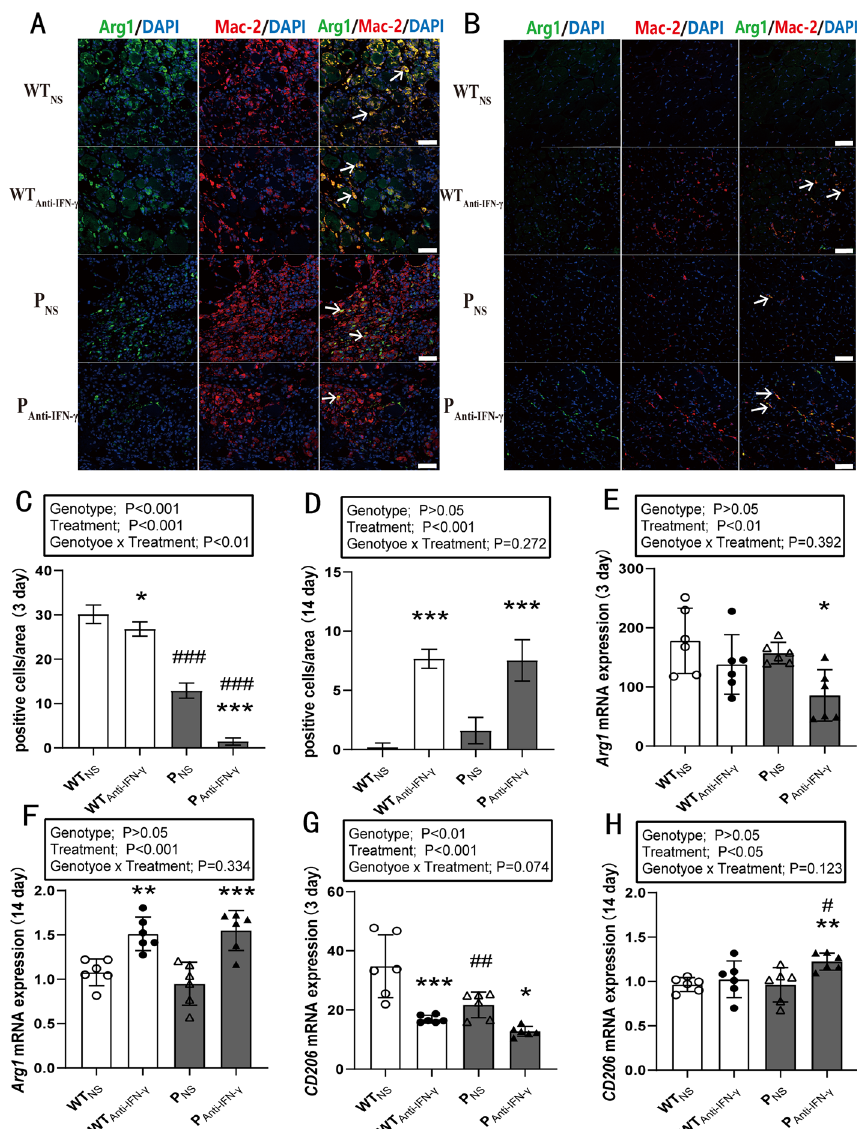
Fig. 5 IFN-γ blockade after PD-1 knockout reduces anti-inflammatory macrophage activation in injured skeletal muscle. WT NS : wild-type injured group with normal saline injection, WT Anti-IFN-γ : wild-type injured group with Anti-IFN-γ antibody injection, P NS : PD-1 − / − injured group with normal saline injection, P Anti-IFN-γ : PD-1 − / − injured group with Anti-IFN-γ antibody injection. A Representative double immunofluorescence staining of Arg1 and Mac-2 at 3 days post injury, B representative double immunofluorescence staining of Arg1 and Mac-2 at 14 days post injury, C quantification of anti-inflammatory macrophages per field as in A , D quantification of anti-inflammatory macrophages per field as in B , E Arg1 mRNA expression at 3 days post injury, F Arg1 mRNA expression at 14 days post injury, G CD206 mRNA expression at 3 days post injury, H CD206 mRNA expression at 14 days post injury. * P < 0.05, ** P < 0.01, *** P < 0.001, different from NS treatment when comparing the same genotype. # P < 0.05, ## P < 0.01, ### P < 0.001, different from WT mice when comparing the same treatment. Data are shown as mean standard deviation (SD), n 3 ( C , D ), n 6 ( E – H ). ± = = White scale bar, 50 μm. Anti-inflammatory → (AKT) phosphorylation induced by TGF-β stimulation, thereby reducing muscle fibrosis [43]. As a TGF-β signaling pathway inhibitor, IFN-γ reduces fibrosis formation in a lac- eration model [44]. IFN-γ null mice also exhibit enhanced tissue fibrosis when compared